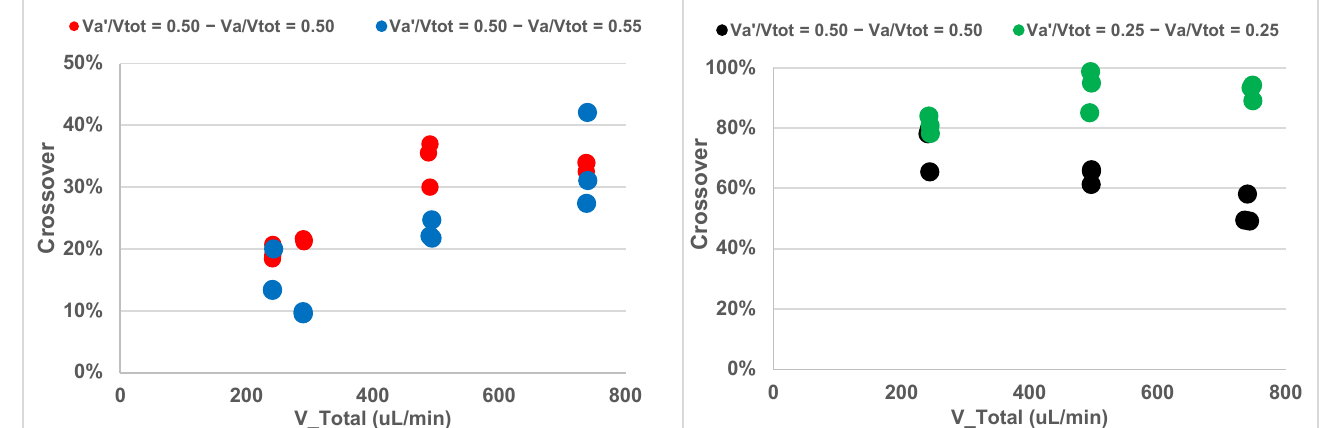
Figure 3. Nonspecific crossover of healthy, oxyRBCs as a function of total flow rate ( left ). The inlet streams remain constant between the two transport lamina conditions, but the blue dataset slightly resists flow in the enriched (b) outlet. This condition has, on average, 7% less crossover than the red dataset with an outlet cutoff closer to the center of the rod. The crossover of healthy, paramagnetic metRBCs as a function of total flow rate is also shown ( right ). Both experiments have inlet and outlet streams with the same cutoffs but compare different interfacial radii. The far boundary (black) dataset has decreasing crossover while the near boundary (green) dataset has more crossover with greater V̇ Total . The reasons for this short distance of radial travel have to do with the inertial equilibrium that the lift force guides the RBCs to, as well as short residence times that the paramagnetic RBCs spend inside the magnet.